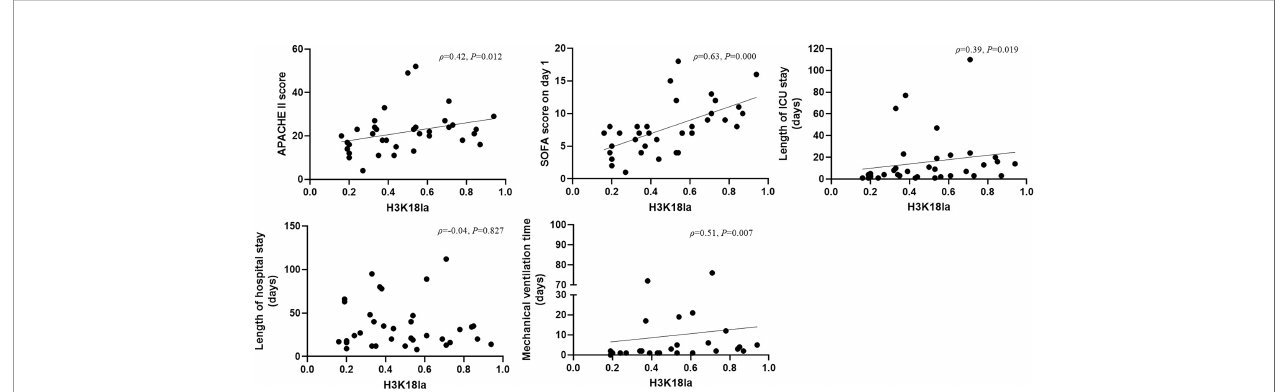
FIGURE 3 | H3K18 lactylation correlation with severity and prognosis. H3K18la has a positive correlation with the APACHE II score, SOFA score on Day 1, length of ICU stay and mechanical ventilation time (Spearman correlation coef fi cient 0.42, 0.63, 0.39 and 0.51, respectively; P =0.012, 0.000, 0.019 and 0.007, respectively). H3K18la, relative density of H3K18 lactylation in western blotting. ICU, intensive care unit; IQR, inter quartile range; APACHE II score, acute physiology and chronic health evaluation II score; SOFA, sequential organ failure assessment. P values below 0.05 indicate statistical signi fi